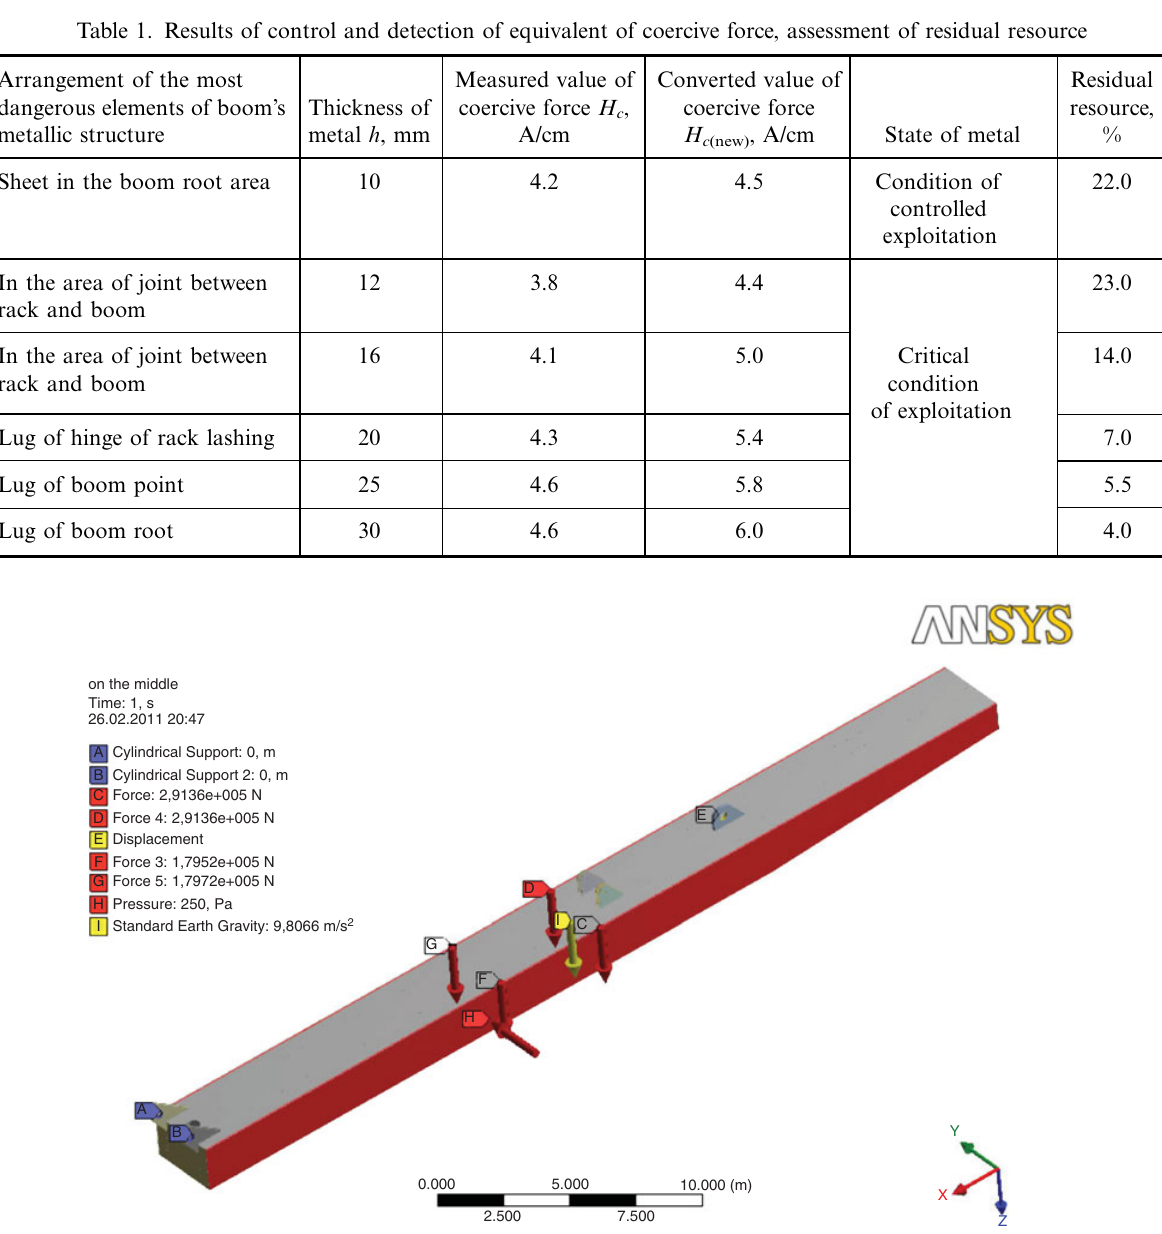
Fig. 3. Trolley with container is between root hinge of console and clamping hinge of console (boundary conditions)